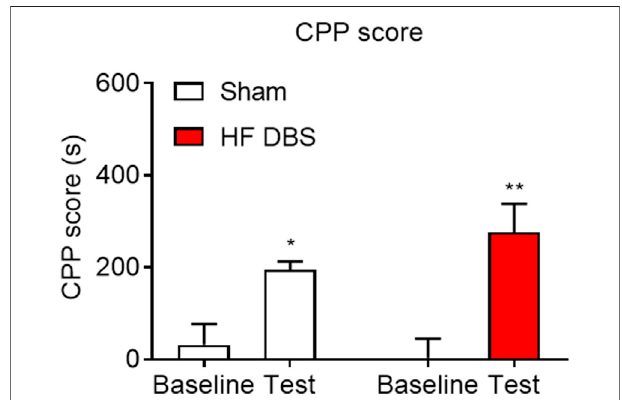
FIGURE 5 | HF DBS of the SNr had no effect on the formation of methamphetamine-induced place preference. Both sham DBS and HF DBS groups exhibited a signi fi cant preference for the drug-paired side after the methamphetamine conditioning (1 mg/kg), while no difference was found in the CPP scores between the two groups. Data are shown as mean ± SEM.* p < 0.05(sham DBS)and ** p < 0.01(HF DBS)comparedwithbaseline. Sham DBS: n (cid:2) 8; HF DBS: n (cid:2)